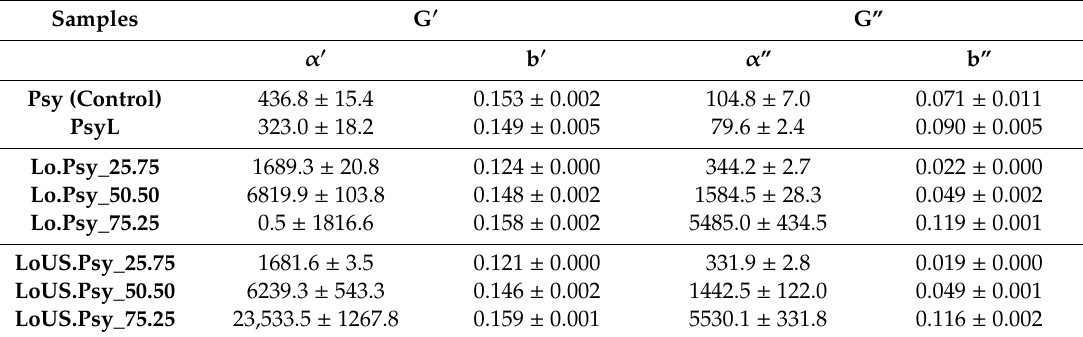
Table 3. Power law parameters ( α (cid:48) , α ”, b (cid:48) , and b”) of the gel samples with Laminaria ochroleuca and Psyllium husk, control, and